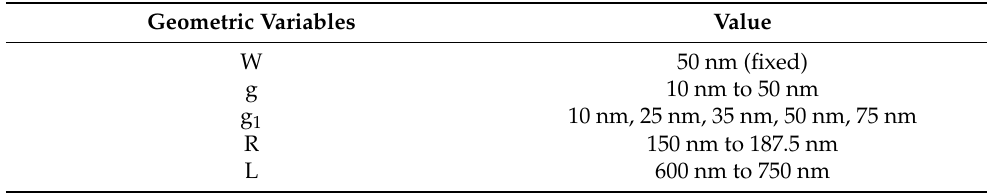
Table 1. Geometric parameters of the device.